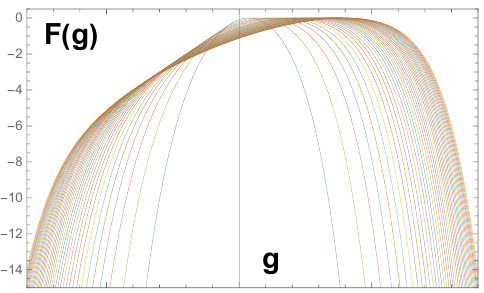
Figure 7: (Color online) Evolution of the function F ( g ) with increasing disorder for the model of ε β Eq.(90) of Ref. [ 13 ] for disorder strengths W = 3.2 − 20.6 at the band center E = 0. At weak disorder F ( g ) approaches the parabolic form, while at F ( g ) strong disorder it has a wide segment of quasi-linear behavior. The derivative ∂ g < 0 where the derivative is 1 is symmetric at g = 0 is equal to 1 / 2, while the point g 1 > 0 of a maximum. The quantity F ( 0 ) depends on disorder strength to the point g 0 W and decreases with increasing W . The localization transition in the infinite system corresponds to F ( 0 ) = −